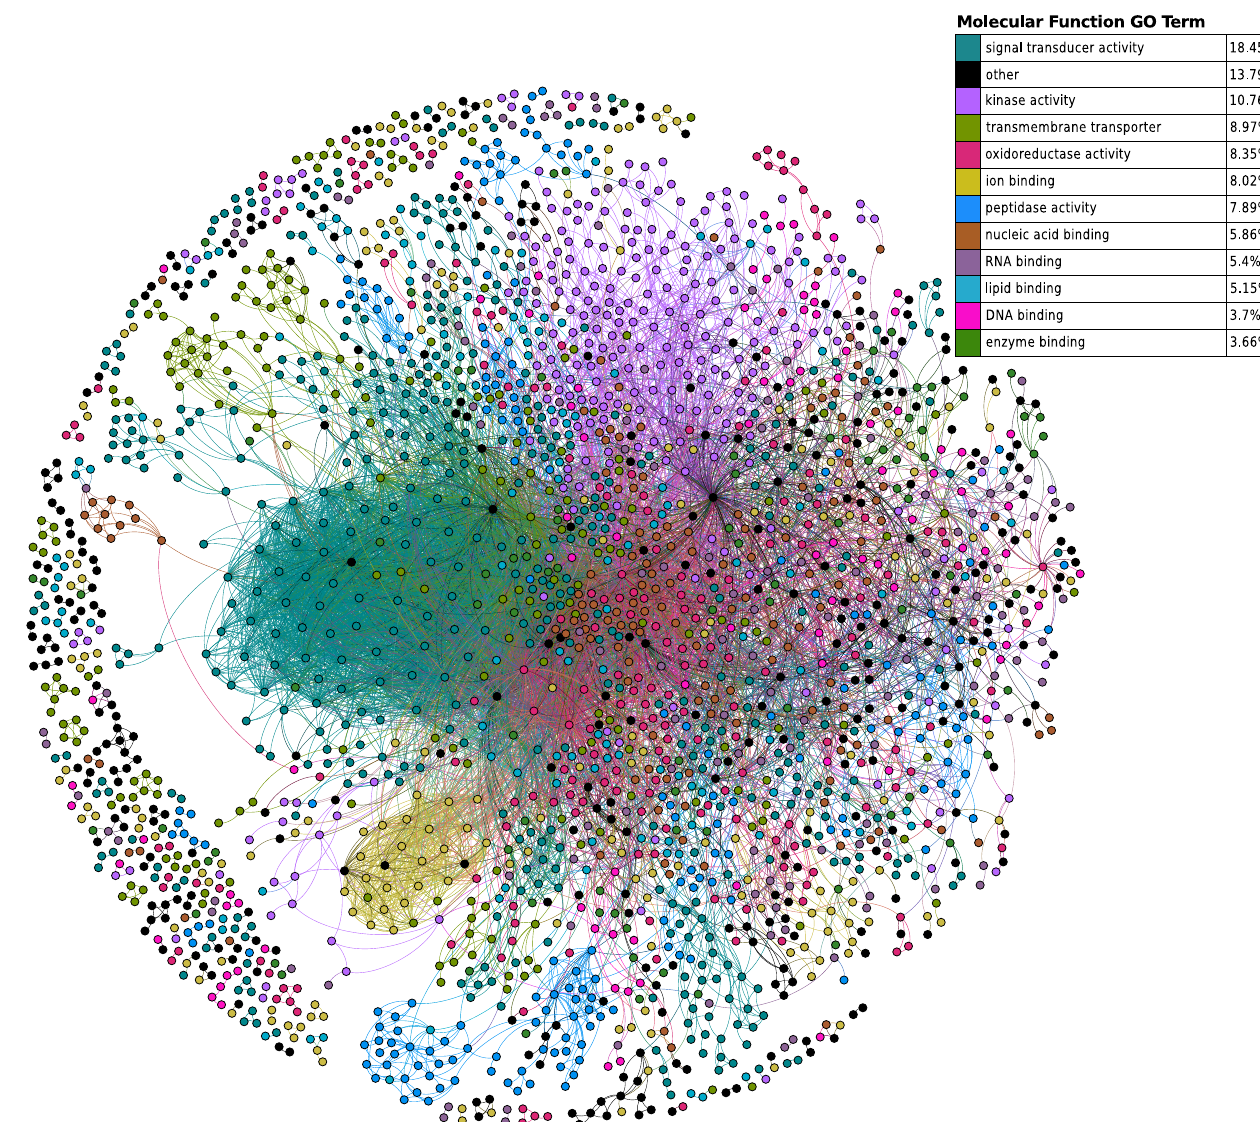
Fig 10. Target-protein network and Molecular Function Gene Ontology Slim (MF GO Slim). Each node represents a protein target, and edgesconnect any two protein targets with greater than 50% bioactivitysimilarity across non-promiscuous bindingcompounds. Targets are colored accordingto MF GO Slim terms, with unannotated targets colored black. Shownare 2407 nodes (target proteins with at least one edge) and 11317 edgesrepresentingshared bioactivity amongthe mutually screenedsubset of the 1.2M compoundstested in the bioassays we analyze in this